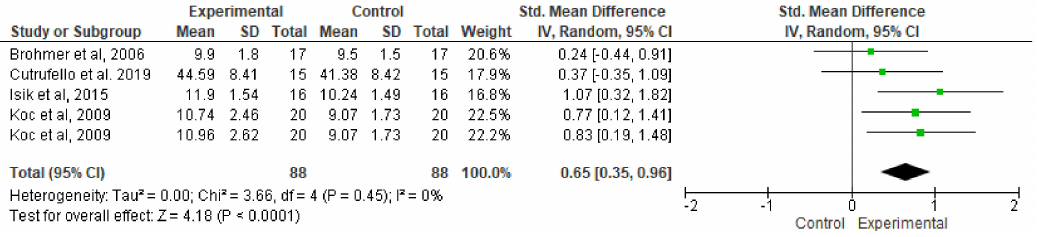
Figure 4. Forest plot comparing the e ff ects of music on relative peak power